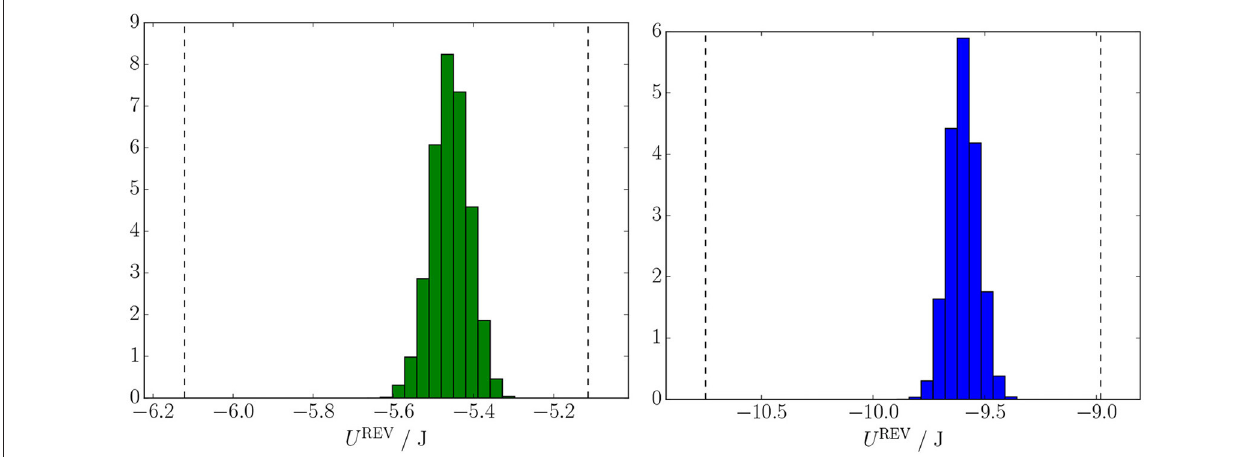
FIGURE 4 | Probability distributions of internal energy in two the candidate REVs. The left candidate REV (green) is 5.2 × 6 mm and the right candidate REV (blue) is 10.4 × 12 mm. In each plot, the left dashed line represents the internal energy the candidate REV would have if it contained non-wetting fluid only and the right dashed line represents the internal energy the candidate REV would have if it contained wetting fluid